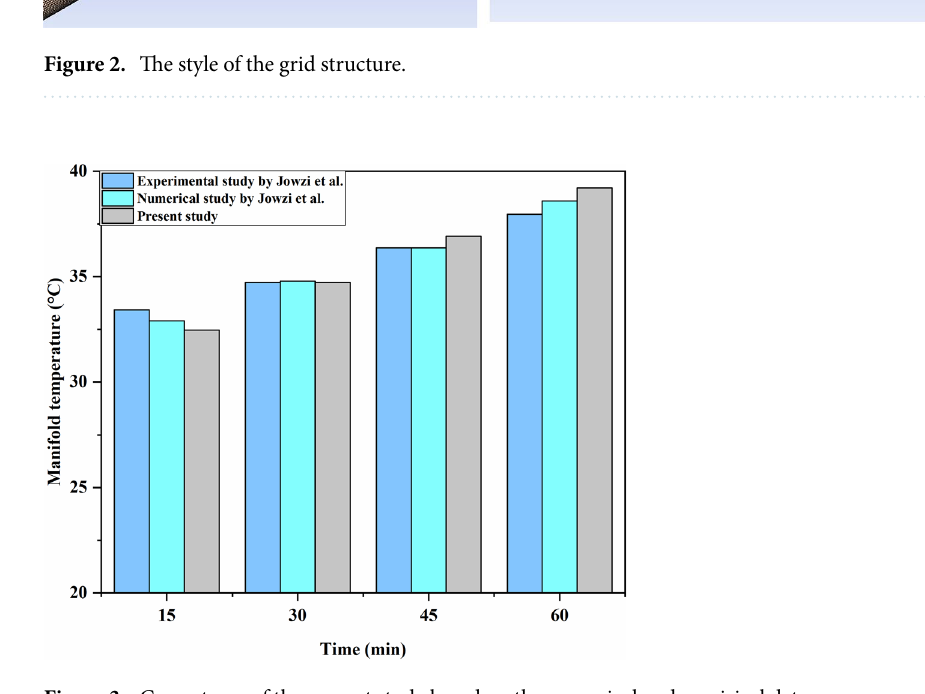
Figure 3. Correctness of the present study based on the numerical and empirical